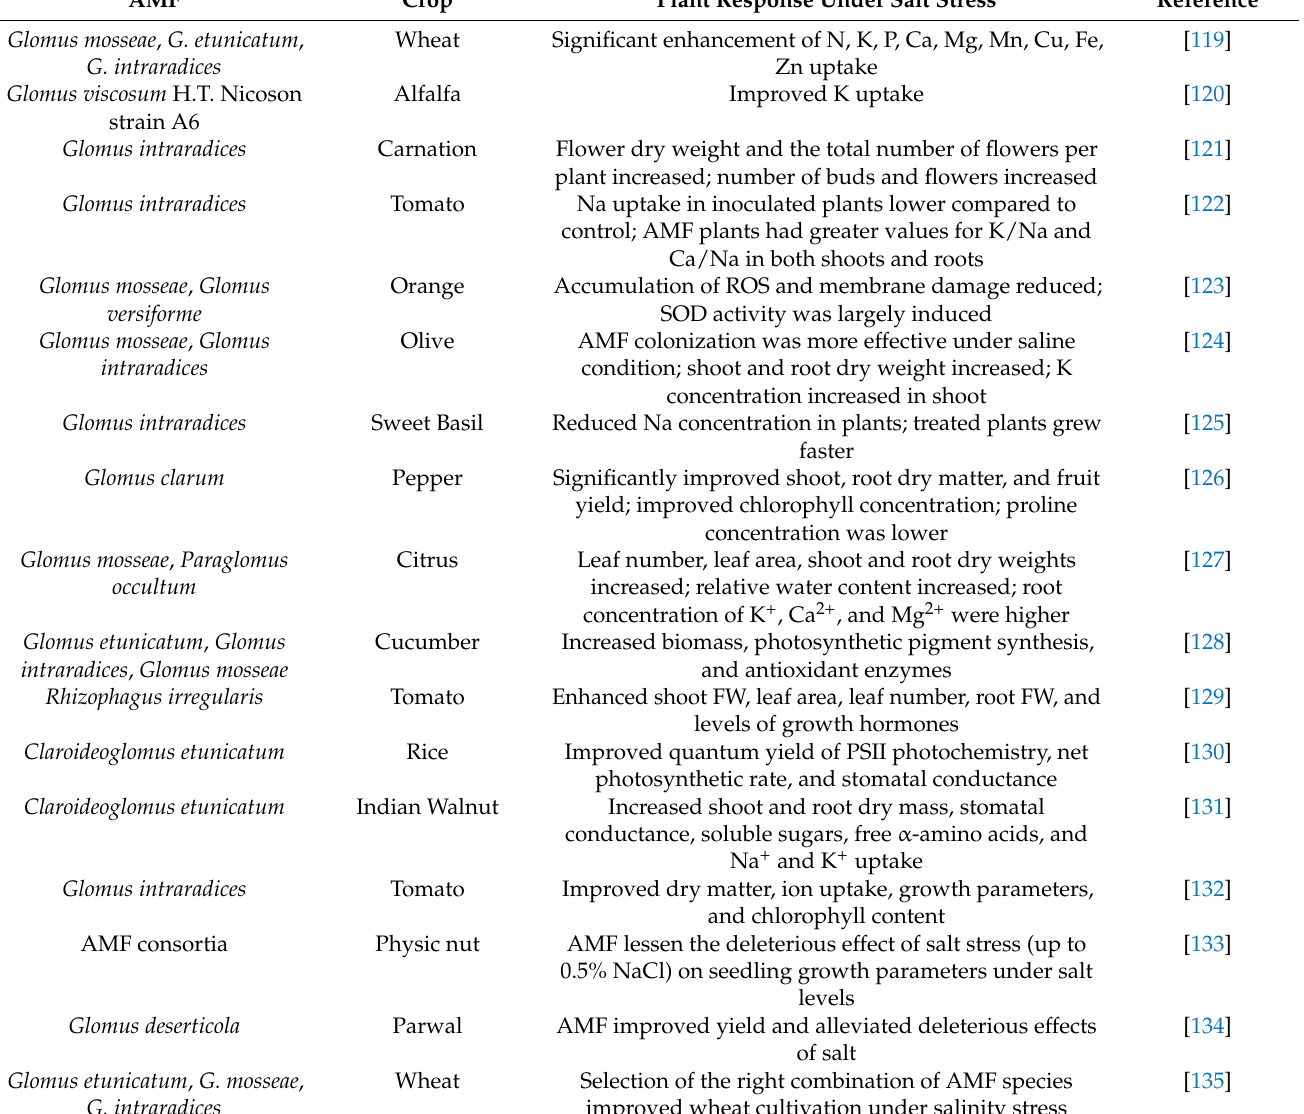
Table 3. Response of AMF on different plants against salinity